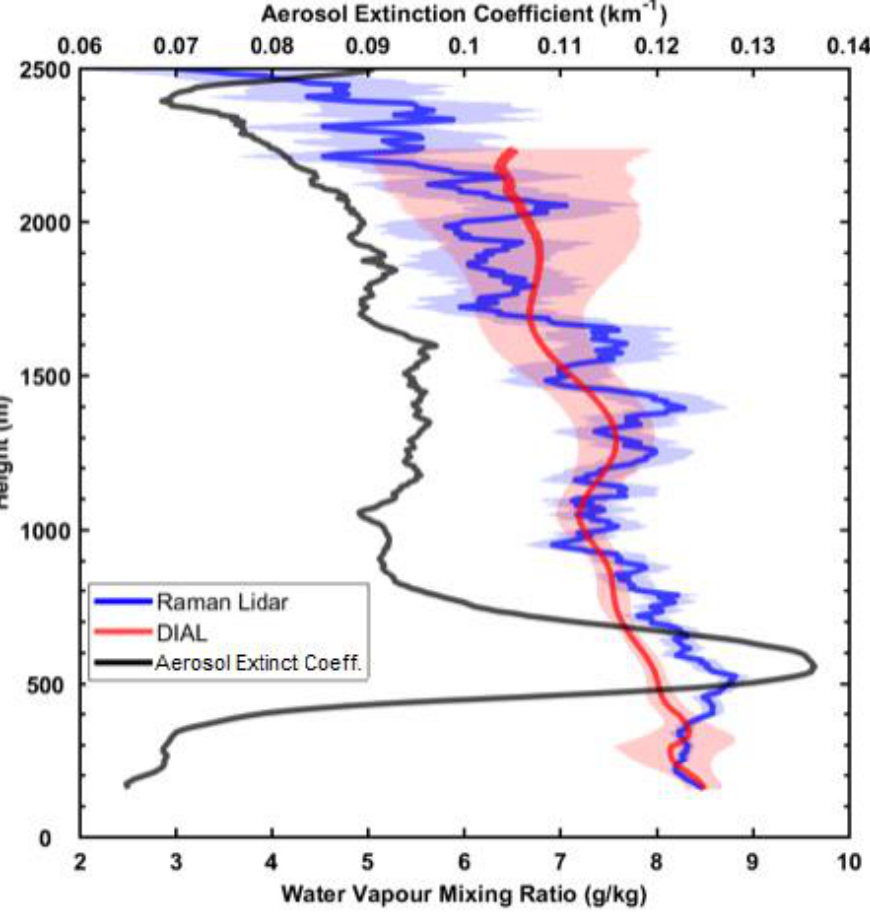
Figure 3. Comparison of observed water vapor mixing ratio profiles averaged over 20 min starting at 03:40 (UTC) on 11 July 2018. The profile uncertainty (shaded region) and aerosol extinction coefficient derived from the York Raman Lidar measurements (black) are also shown.